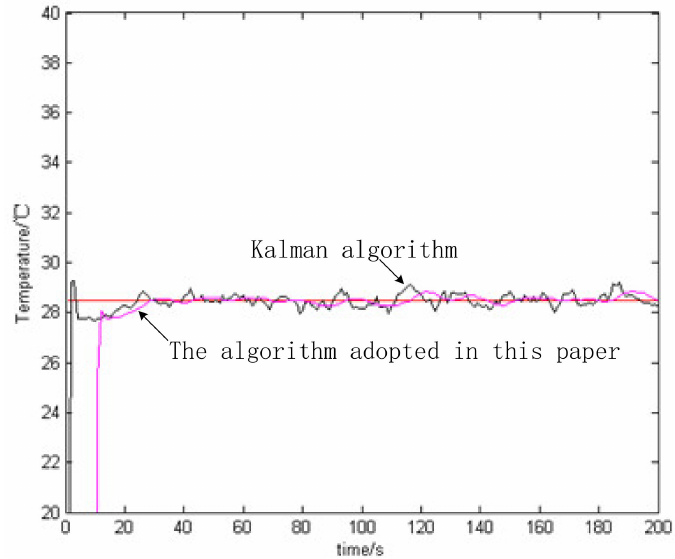
Figure 10. Comparison of Kalman filtering and Kalman smooth